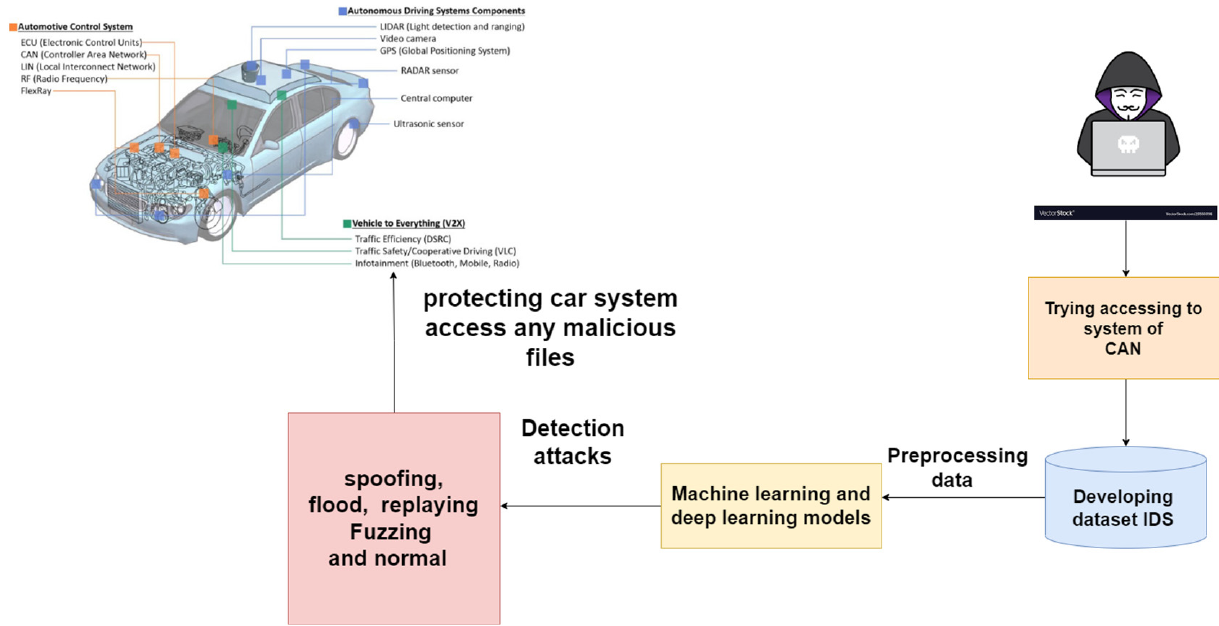
Figure 3. Framework of a CAN-based IDS.